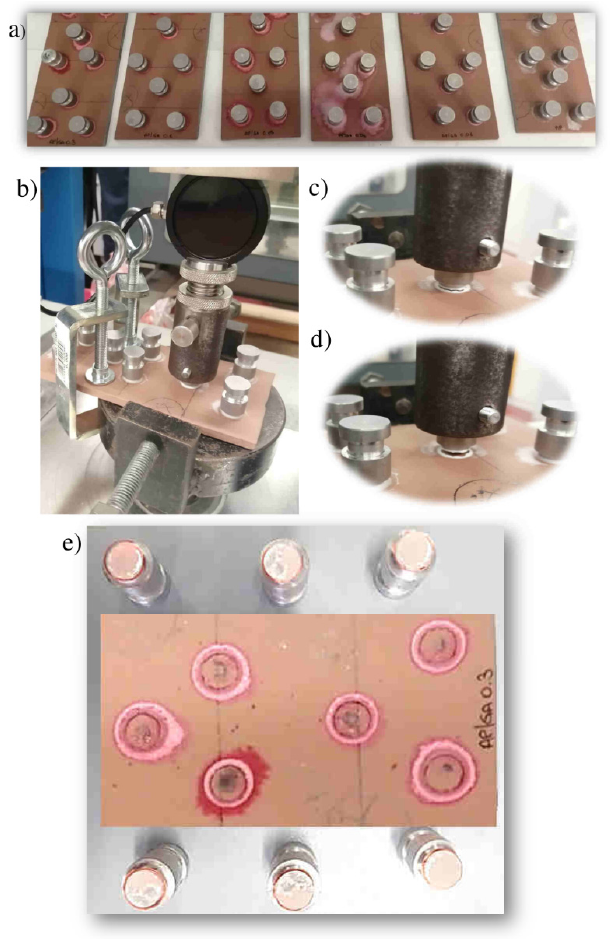
Figure 8. Pull-off Test: Image of the samples ( a ); fixing and stretching phase of the dolly in the dynamometer ( b ); step of breaking the specimen from the metal substrate ( c , d ); image of the metal specimen and the dolly after the pull off test for the sample AP/GA 0.3 ( e ).